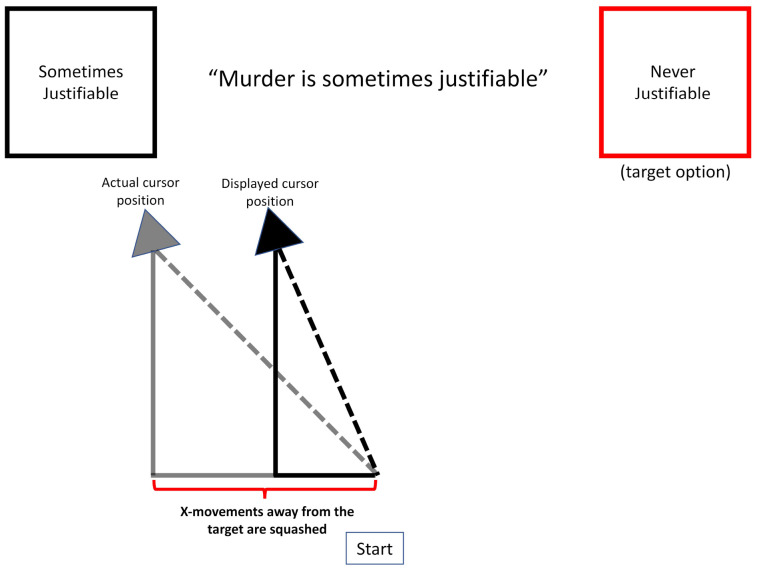
A schematic of the operation of the velocity-squashing manipulation. The change in x-position for movements away from the target are squashed by a factor of 0.45 and the cursor is reset to a new position. For example, on this trial, a cursor movement of 10 pixels to the left would result in a displayed movement of 4.5 pixels to the left. Movements toward the targets are unperturbed.